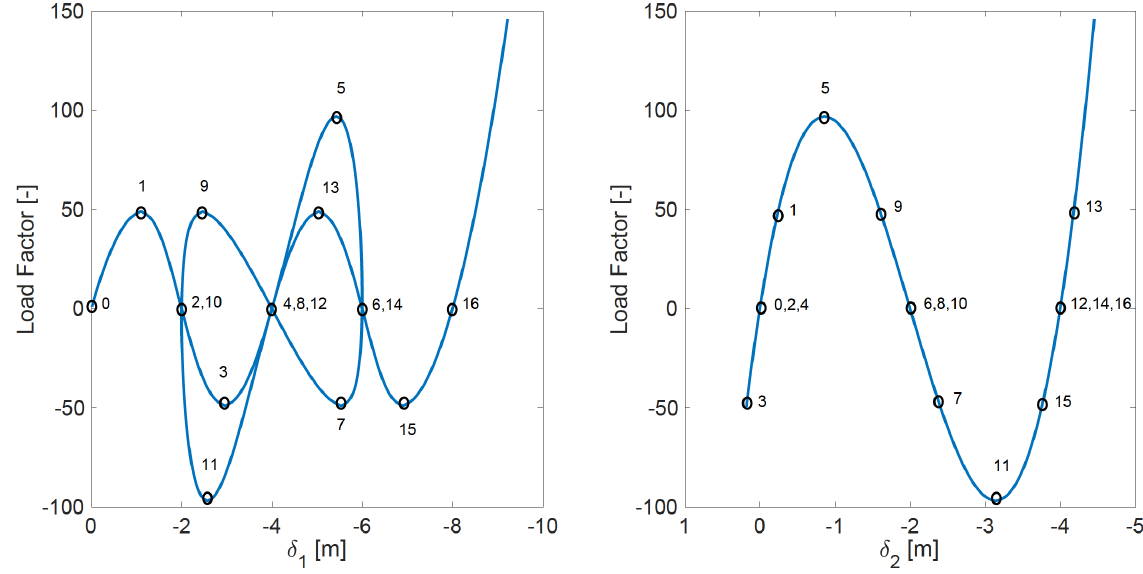
Figure 10: Sixteen-member structure load-displacement curves (Case 1 – λ up = 13.0 )